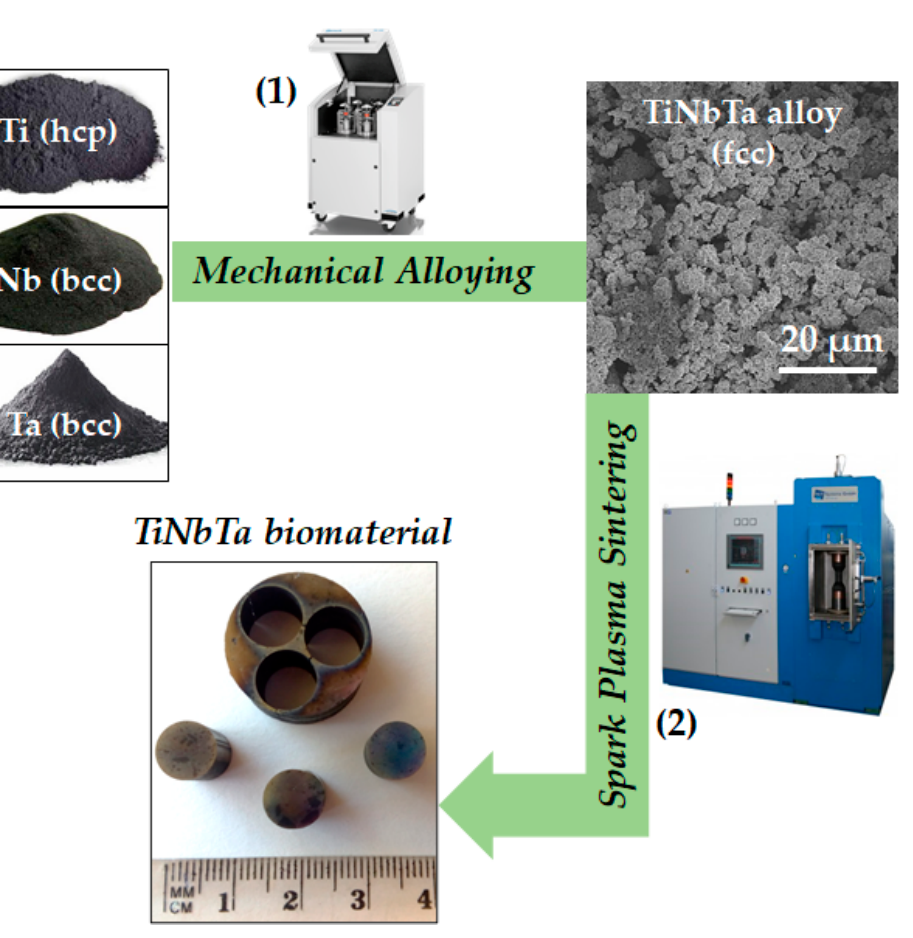
Figure 1. Schema of the powder metallurgy route used for the development of the new potential prosthetic TiNbTa material, showing the evolution of the material from raw elements (Ti, Nb, and Ta) to the synthesized TiNbTa alloy, and, finally, to the fabricated potential prosthetic TiNbTa biomaterial. (1) Image of the PM400 planetary ball mill, courtesy of Retsch. (2) Image of the HPD 25 spark plasma sintering (SPS) device, courtesy of FCT Systeme GmbH.